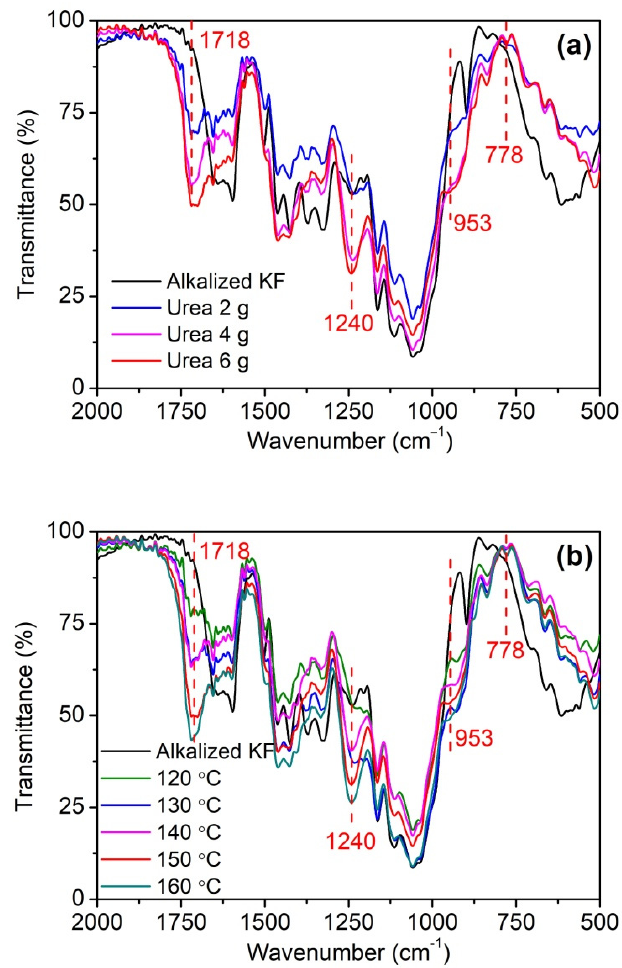
Figure 4. FT-IR spectra of alkalized KF and phosphorylated KF samples obtained at various urea dosages (PA 6 g, urea 2, 4, and 6 g, 150 °C, and 90 min) ( a ) and various temperatures (PA 6 g, urea 6 g, 120, 130, 140, 150, and 160 °C, and 90 min) ( b ).